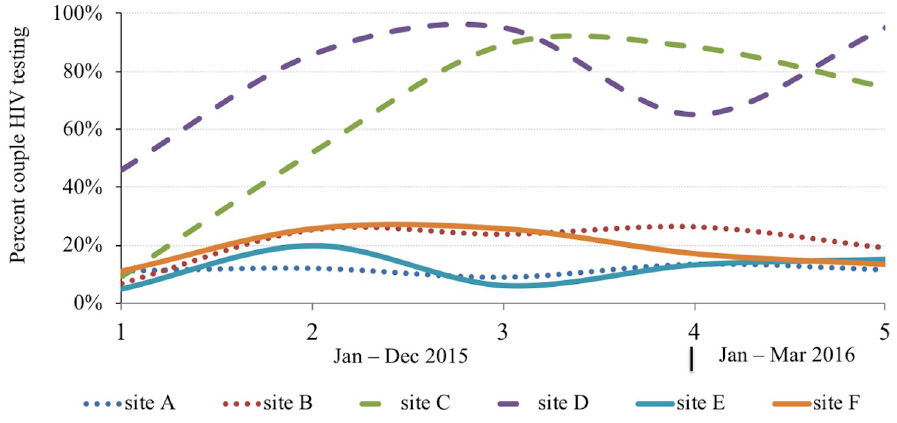
Fig 2. Couple HIV testing rates across quarters at first antenatal care visit at each of the six intervention sites from 1 st January– 31 st March 2015 to 2016.